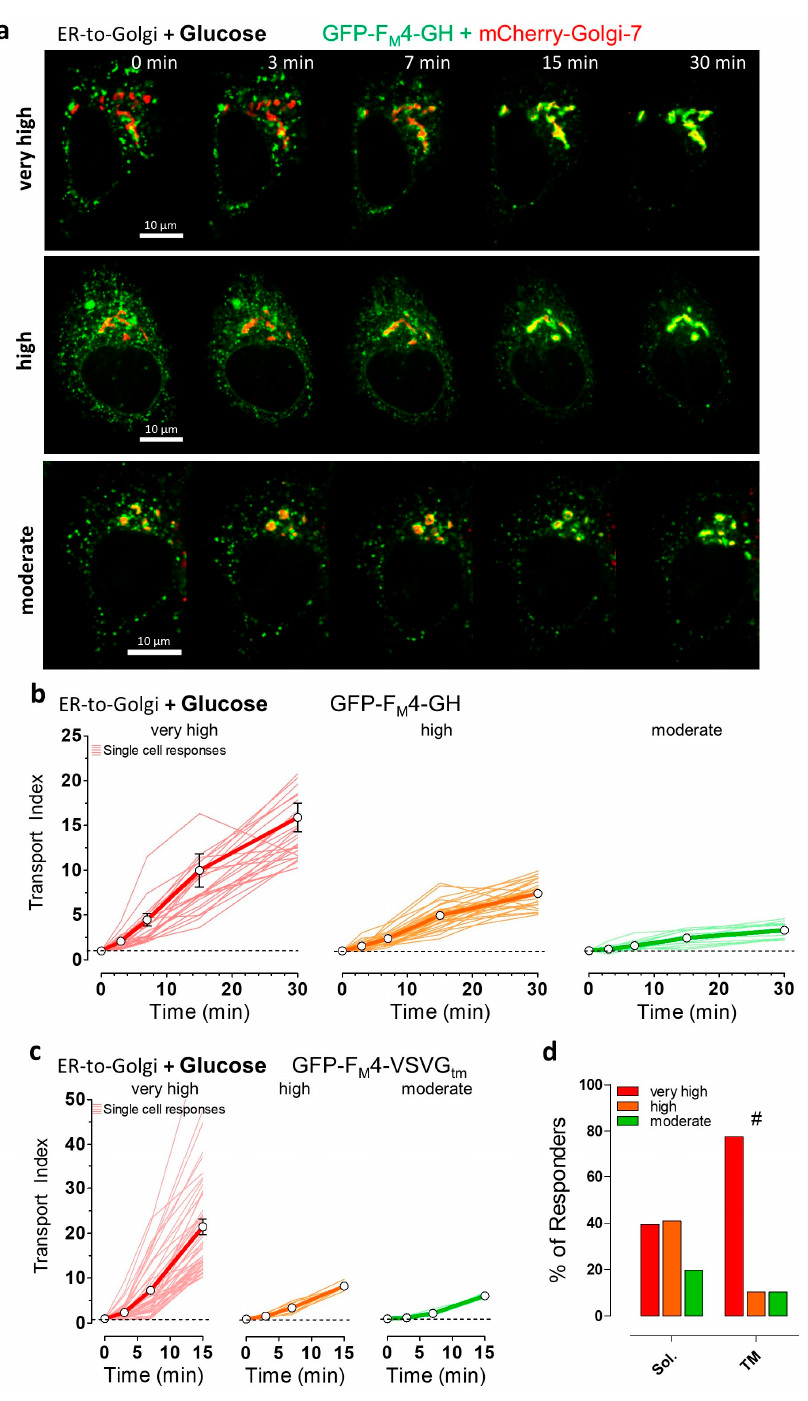
Figure 1. Visualization and classification of synchronized endoplasmic reticulum (ER)-to-Golgi transport in HeLa cells using soluble and transmembrane fluorescent protein (FP)-labeled cargos. ( a ) Representative images showing HeLa cells expressing GFP-F M 4-GH, soluble cargo construct (in green), and mCherry-Golgi-7, Golgi marker (in red), and merged signals (in yellow) at the indicated time points upon the addition of 250 nM solubilizer in the presence of 10 mM glucose. ER-to-Golgi transport was classified as very high (upper panel), high (middle panel), and moderate (lower panel). A 100 × magnification objective was used, scale bars indicate 10 µ m in every image of the time course; ( b ) ER-to-Golgi transport of the soluble transport construct, GFP-F M 4-GH in single HeLa cells (thin lines, n = 66 cells from 4 independent experiments) and respective mean ± SEM curves over time upon the addition of 250 nM solubilizer in the presence of 10 mM glucose. Transport efficiency was classified as very high (red curves, transport index >10 at 30 min), high (orange curves, transport